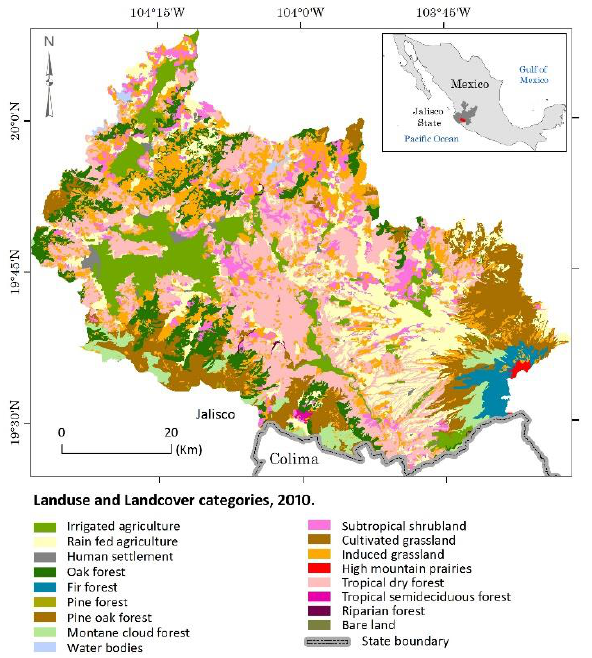
Figure 1. The study area represented by land cover land use map of 2010, including 17 categories, interpreted from Landsat images.